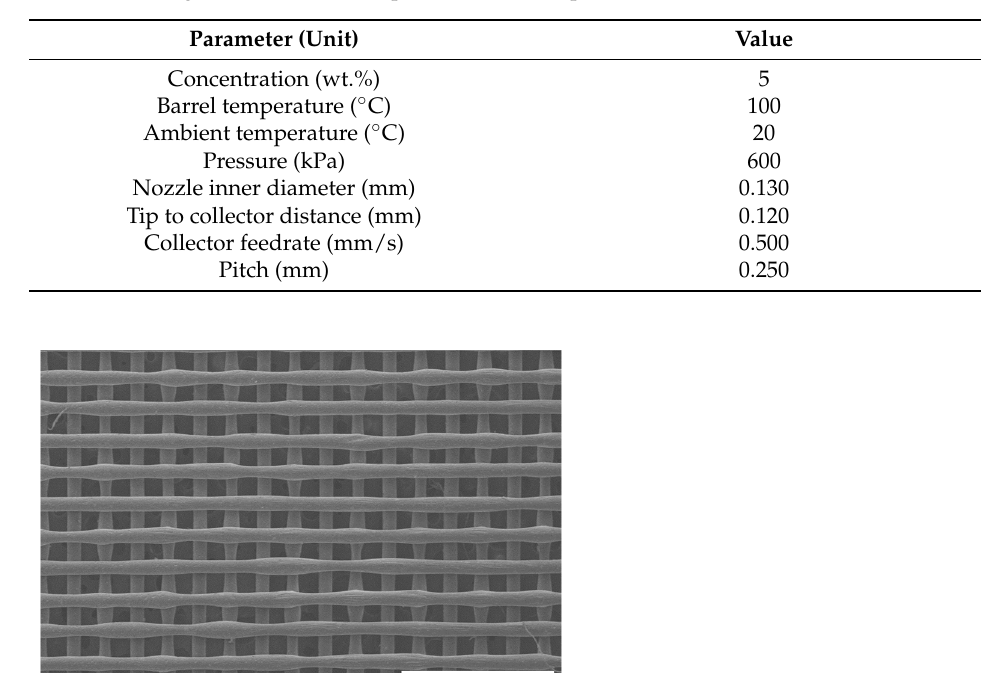
Table 4. Printing conditions for skin patch with lattice-pattern.